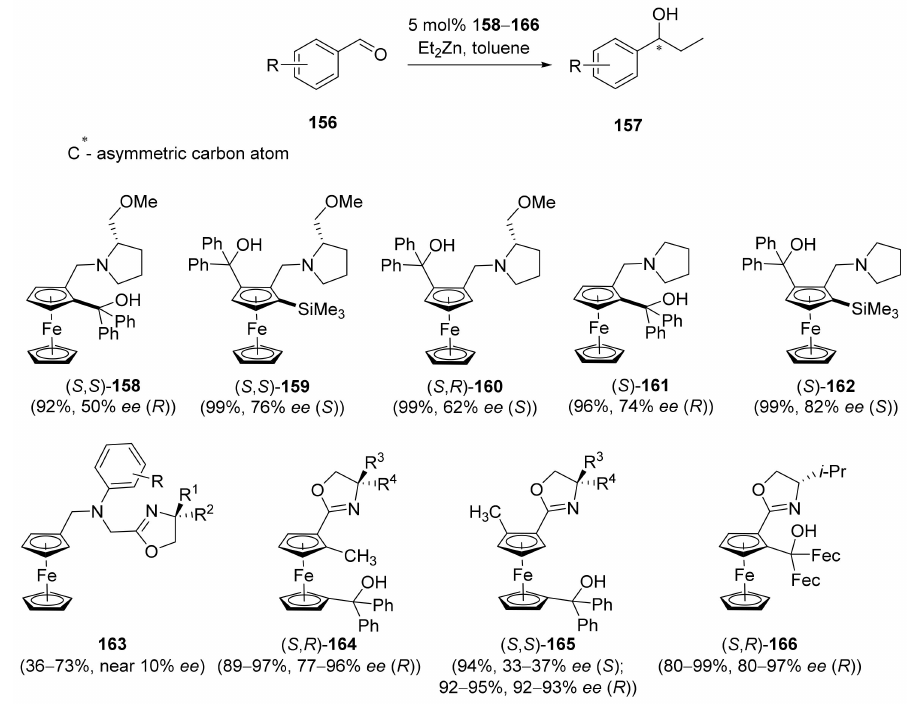
Scheme 35. The enantioselective addition of diethylzinc to